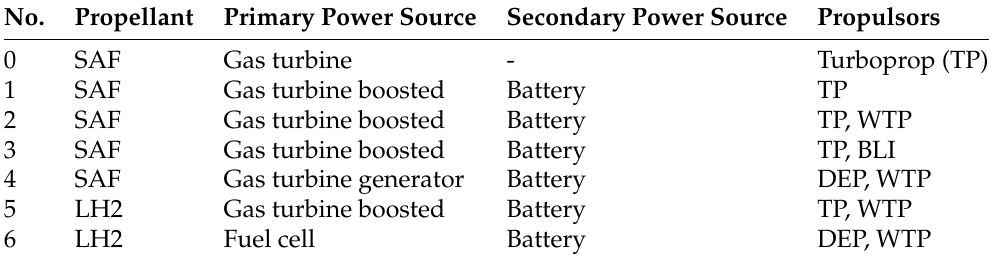
Table 2. Overview of the different architecture variants investigated in the initial sizing process and their individual